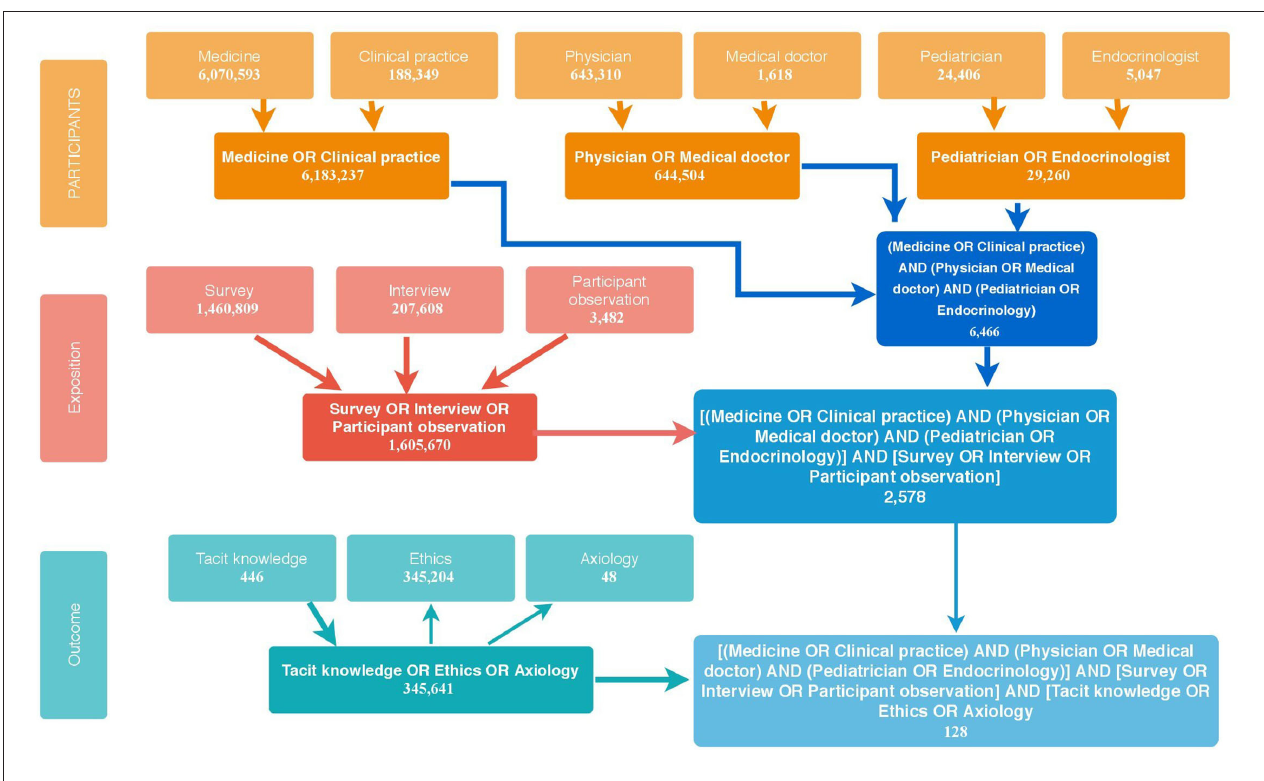
FIGURE 1 | PubMed decision